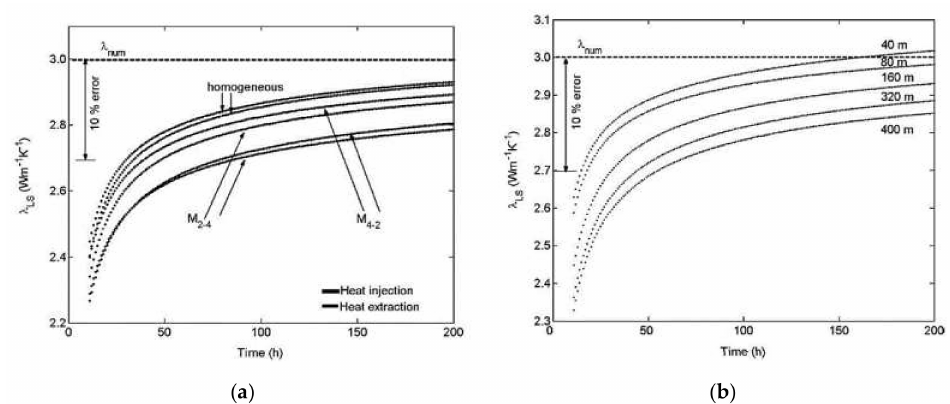
Figure 3. Calculated thermal conductivities based on the line-source model λ LS for di ff erent borehole depth, durations and ground stratigraphy (Rearranged from [21]): ( a ) heterogenous ground layers; ( b ) homogeneous